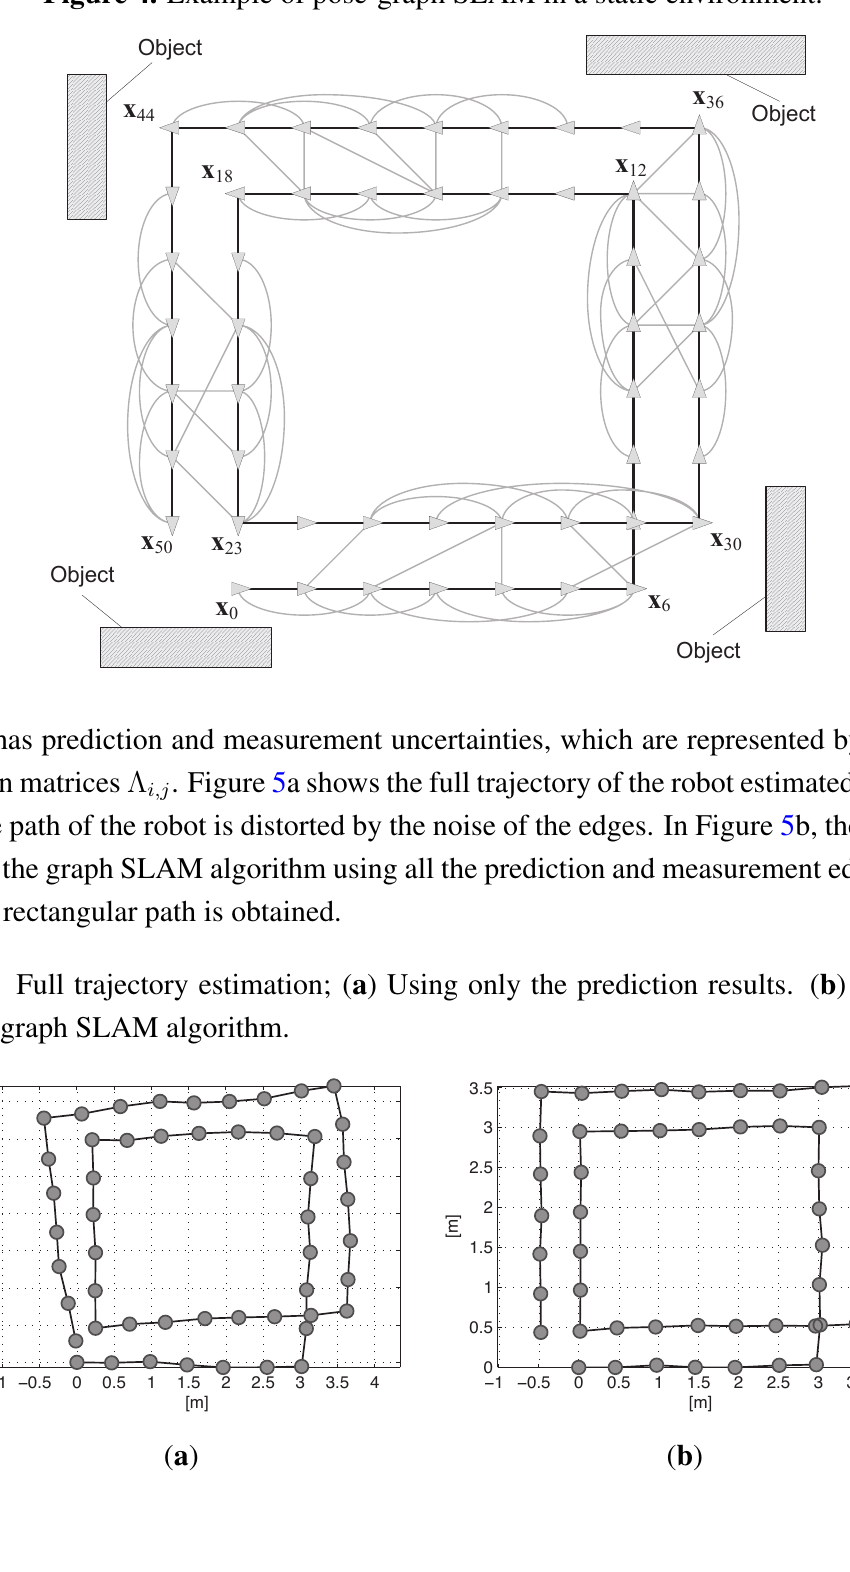
Figure 4. Example of pose-graph SLAM in a static environment.